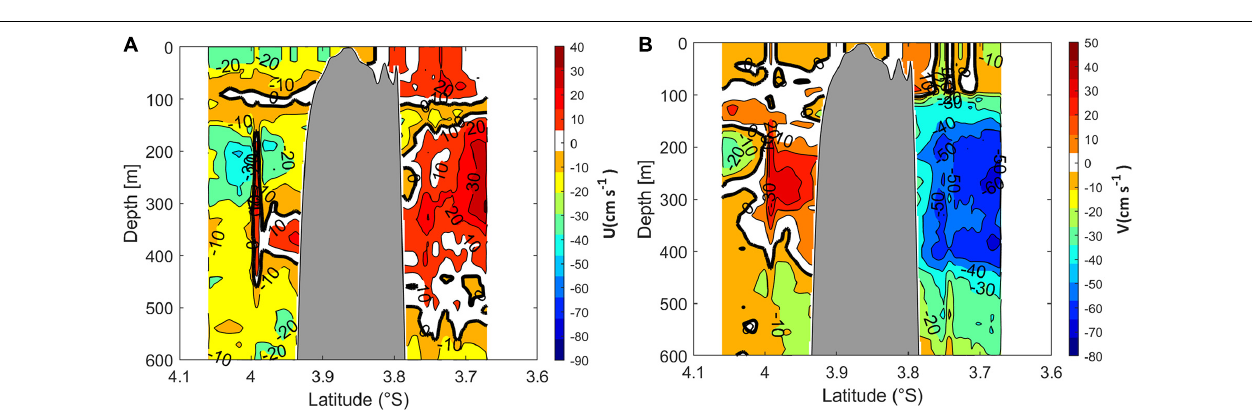
FIGURE 12 | Mean zonal (A) and meridional (B) velocity components (in cm.s − 1 ) during spring 2015 around RA (see Td transect in Figure 2 ). The contour interval is 10 cm.s − 1 . In each panel, the bold black solid line contours represents null value of the velocity.